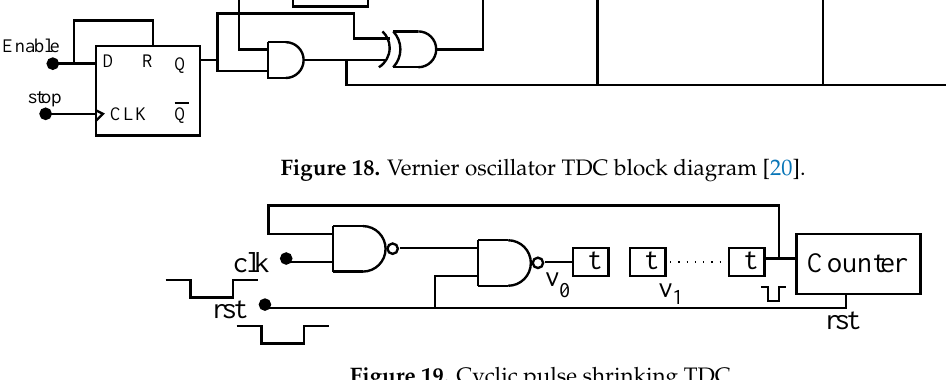
Figure 19. Cyclic pulse shrinking